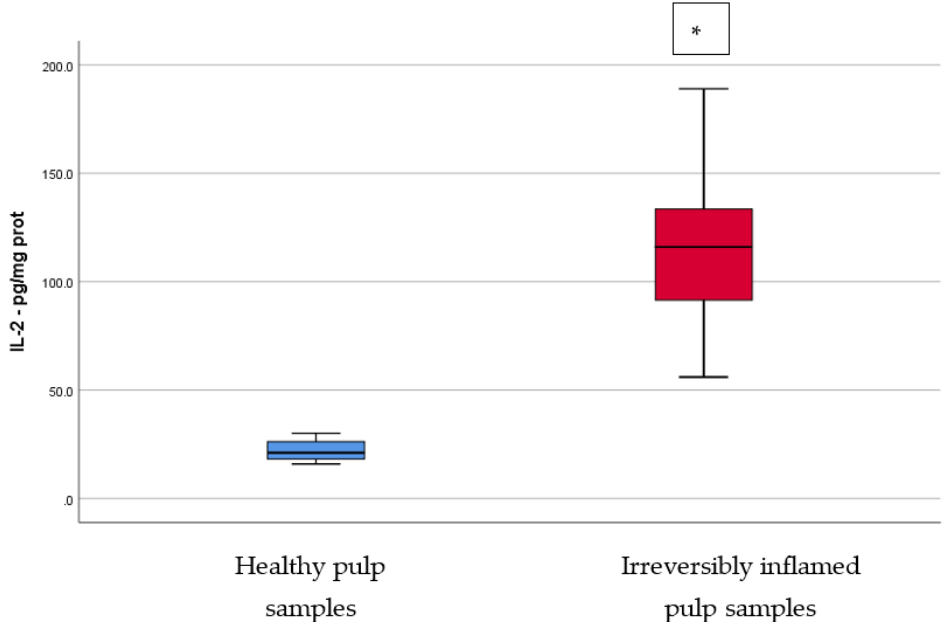
Figure 1. Comparison of IL-2 levels (pg/mg protein) in healthy and irreversibly inflamed dental pulp samples, respectively. The distribution of variables is parametric in both groups according to the Shapiro–Wilk test ( p > 0.05). Welch’s t -test shows that the differences between the two groups are statistically significant ( p < 0.001). (* indicates a statistically significant difference).